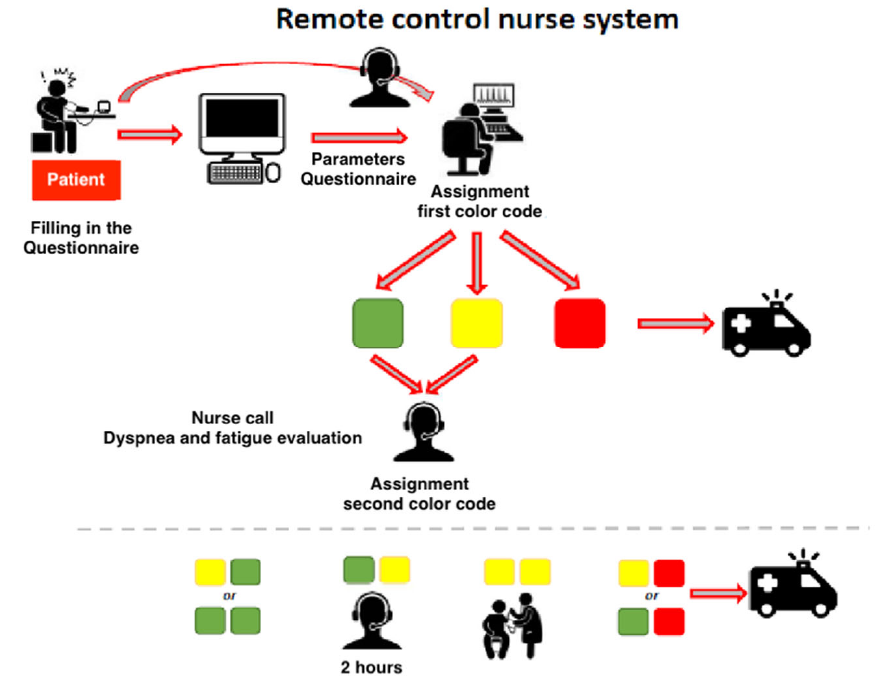
Figure 3. Remote control nurse system.